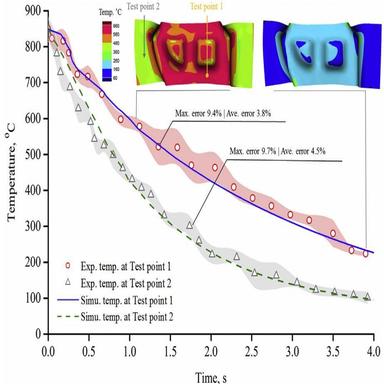
The comparison of the temperature histories of the formed component obtained from the experiment and simulation.